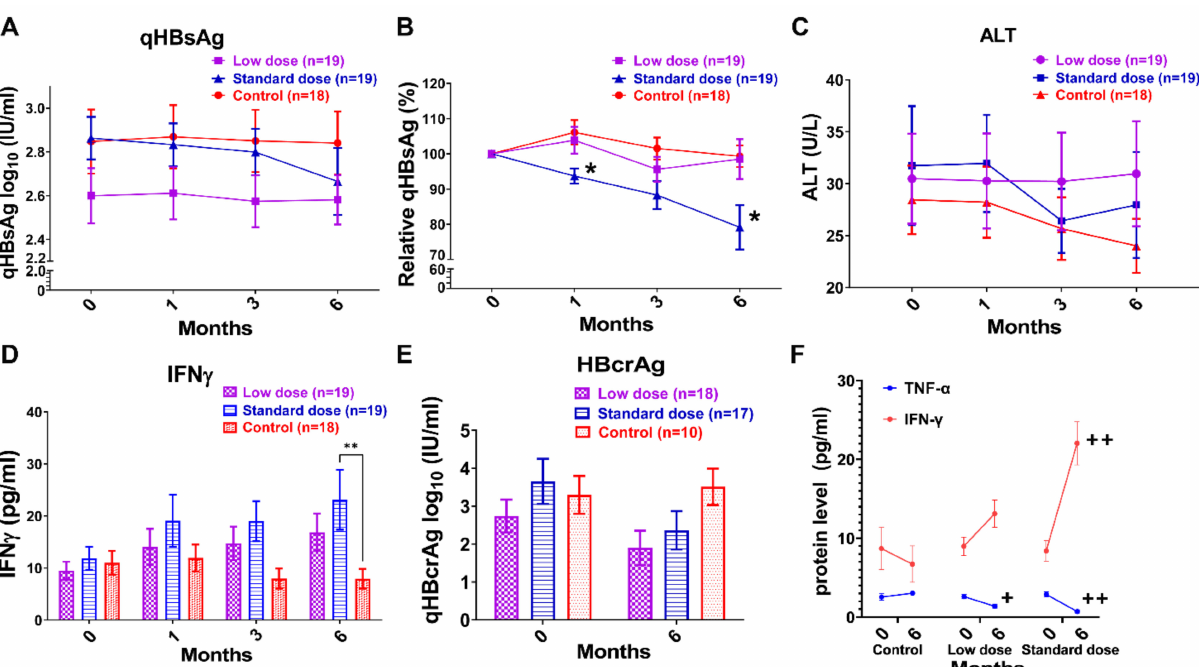
Figure 2. Arthrospira has the potential to reduce serum qHBsAg and qHBcrAg as well as to modulate serum TNF- α /IFN- γ profile in chronic hepatitis B virus infection patients receiving nucleos(t)ide ana- logue (NA) treatment. ( A ) The graph demonstrates the change of serum HBsAg quantity